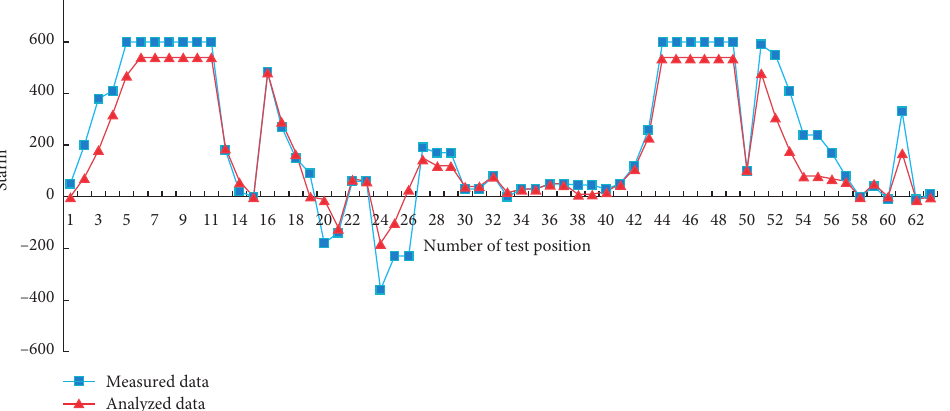
Figure 22: Comparison of measured and finite element numerical calculation results